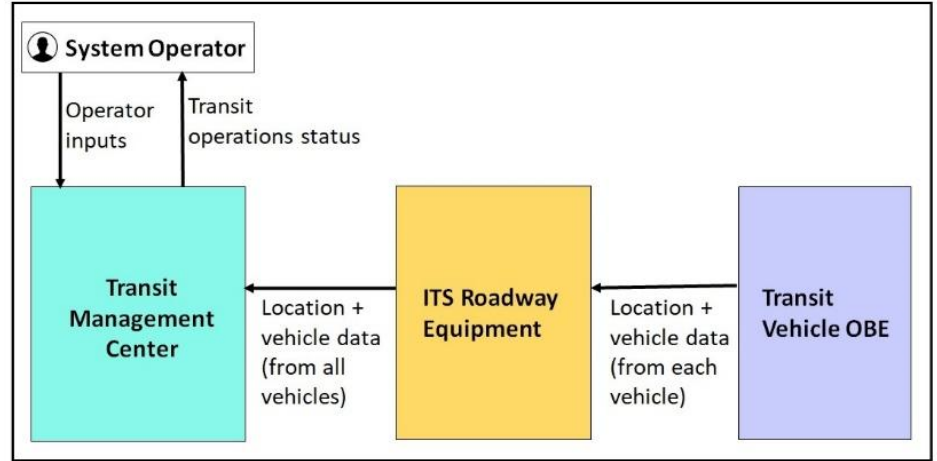
Figure 1. Selected intelligent transport system (ITS) architecture for transit vehicle tracking service.